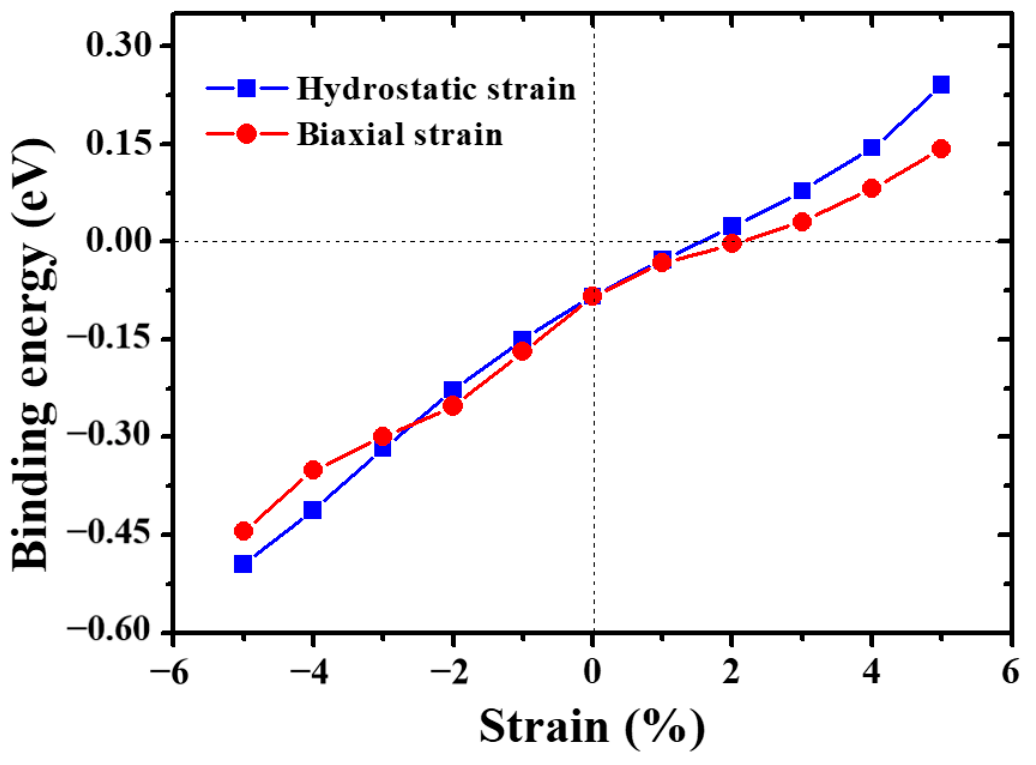
ff ects of hydrostatic and biaxial strain on the binding energy of divacancy in Figure 10. Effects of hydrostatic and biaxial strain on the binding energy of divacancy in W. Figure 10. E